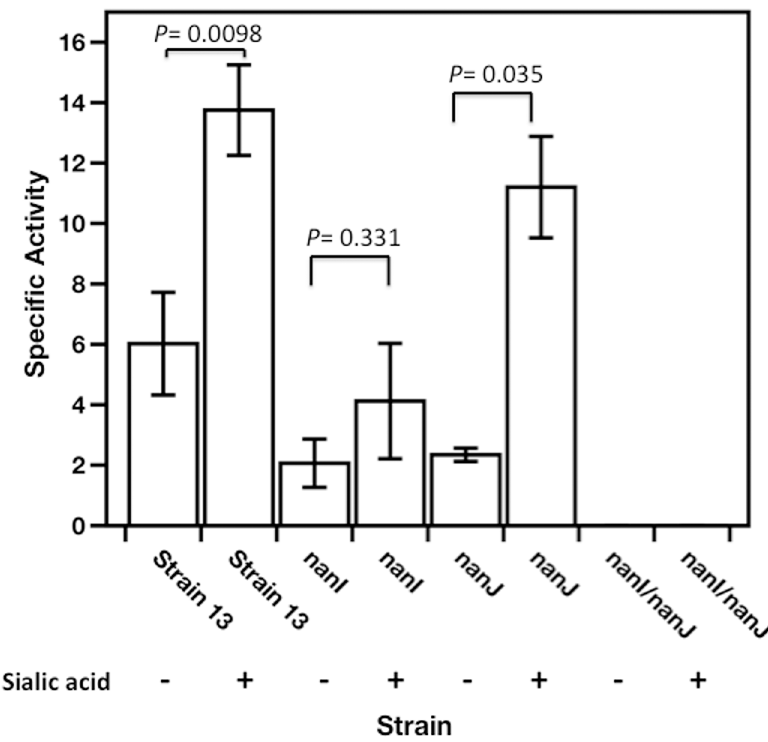
Fig 3. Extracellular sialidase activity of wild-type C . perfringens , BT1 ( nanI ), BT2 ( nanJ ), and BT3 ( nanInanJ ). Cells were grown overnight in 5 ml of PY with (+) or without (-) 1 mg/ml sialic acid as indicated. Sialidase specific activity was defined as μ moles of 4-methylumbelliferyl- α -D-N-acetylneuraminic acid hydrolyzed per minute per milligram of protein. Values shown are the mean and SEM of triplicate biological samples. The P values, calculated using the student's two-tailed t-test, are shown in the